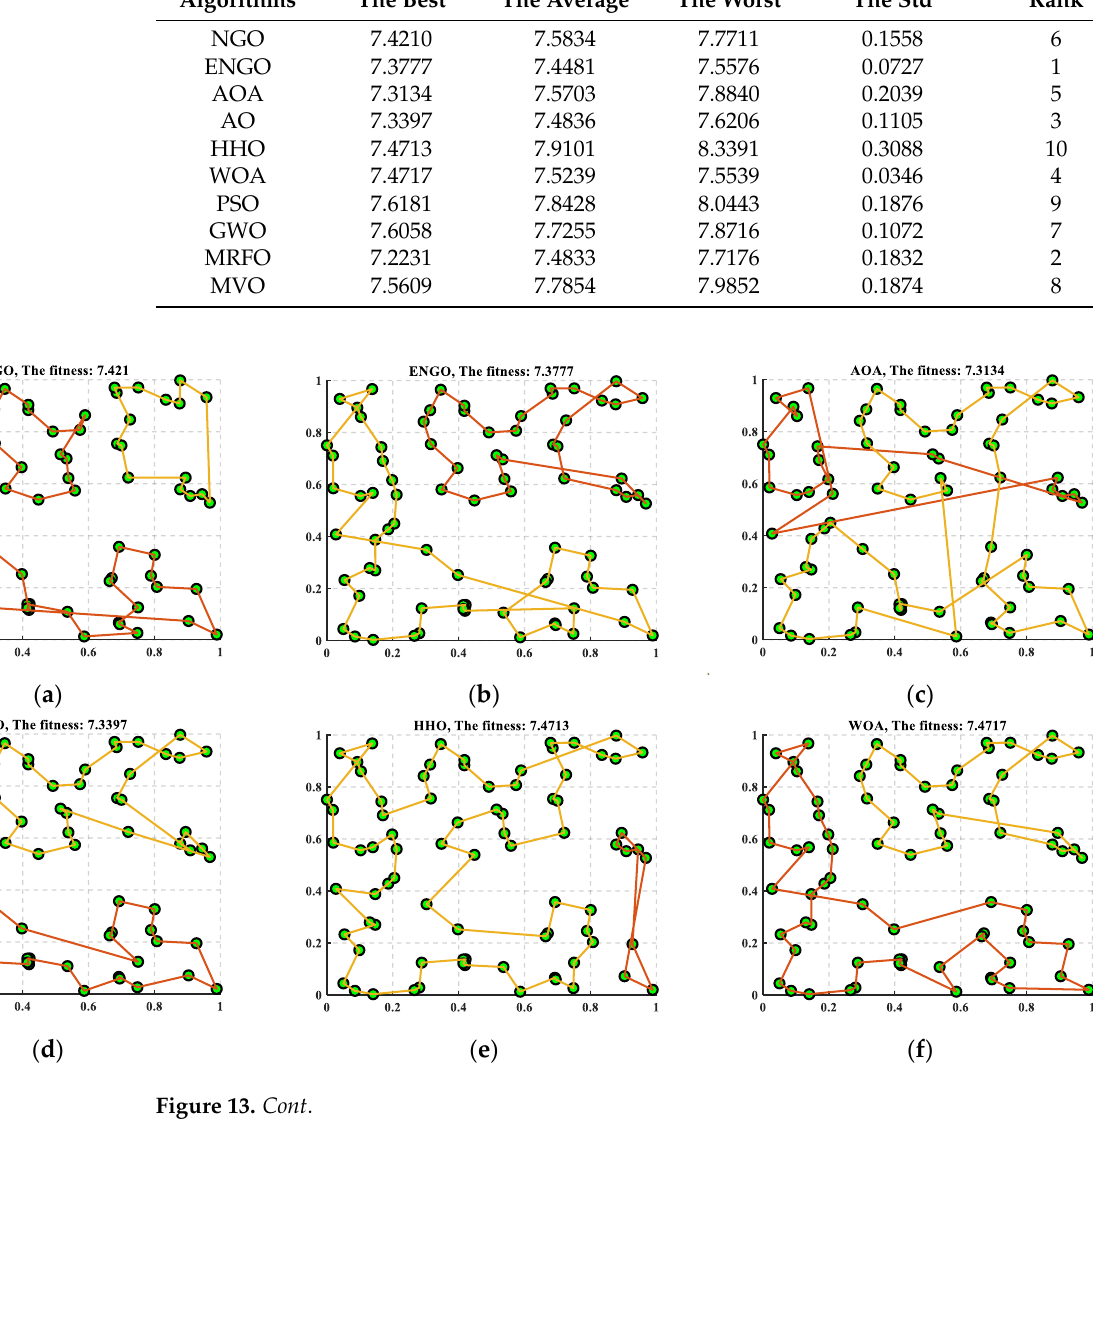
Table 13. The results of the different algorithms for the TSP with 80 cities and two2 traveling salesmen. Algorithms